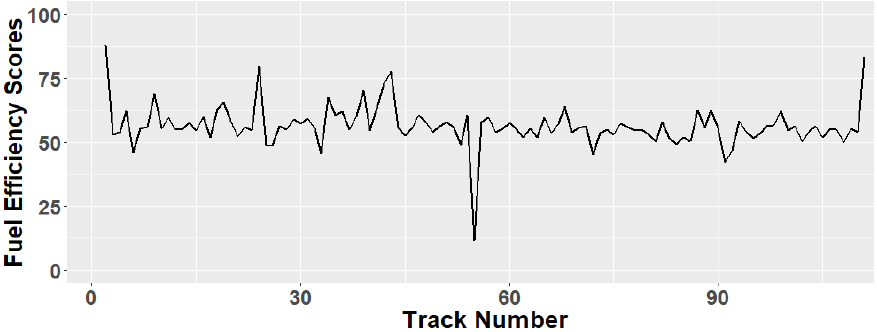
Figure 8. Fuel efficiency scores for 111 tracks for car model “Volkswagen Polo 9N 2009”, gasoline engine.